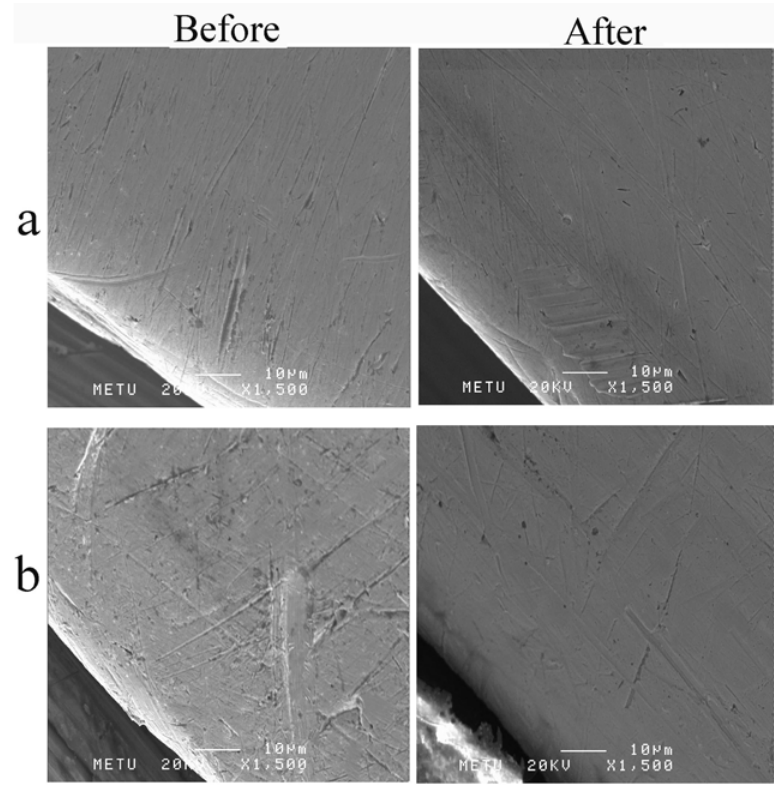
FIGURE 6- SEM images; before and after the potentiodynamic polarization tests (a) C3 (b) C4